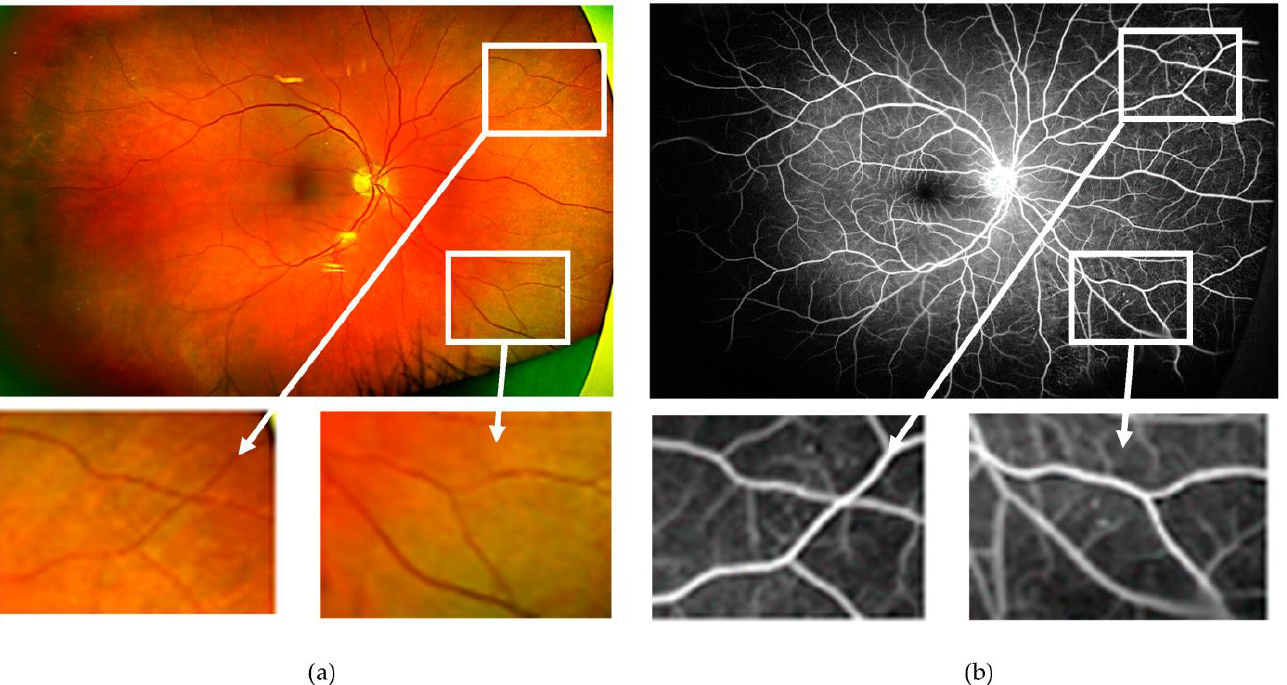
Figure 1. ( a ) Ultra-wide field pseudocolour image obtained from the right eye of a patient with diabetes with “no overt diabetic retinopathy”. Microaneurysms and small areas of capillary drop-out, however, are visible on the corresponding ultra-wide field fundus fluorescein angiogram ( b ). As an example, the two areas with no abnormalities are magnified as detected on the pseudocolour image (bottom left), which showed vascular changes on fluorescein angiography (bottom right).